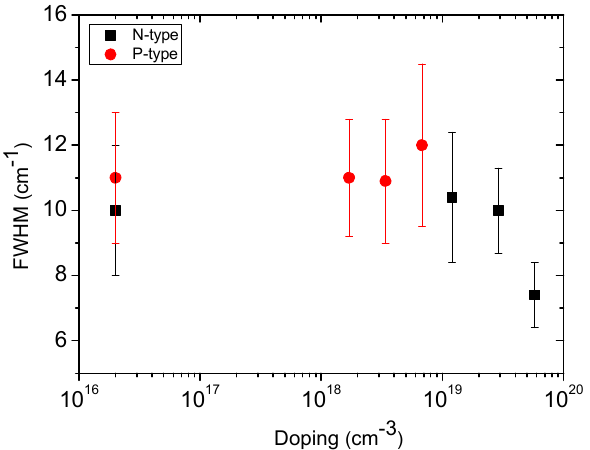
Figure 1. FWHM of the TO peak vs. doping concentration for nitrogen (black squares) and aluminum (red points). N-type and P-type samples were grown on Si (100) off-axis [110] and off- axis [100], respectively.